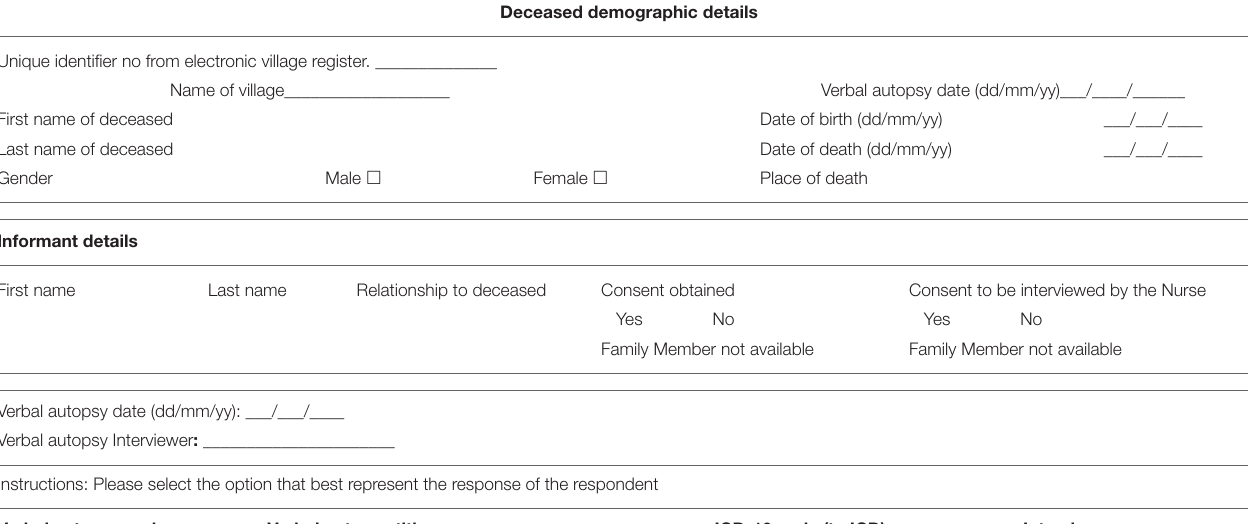
TABLE 1 | Simple verbal autopsy tool for use by village headman.